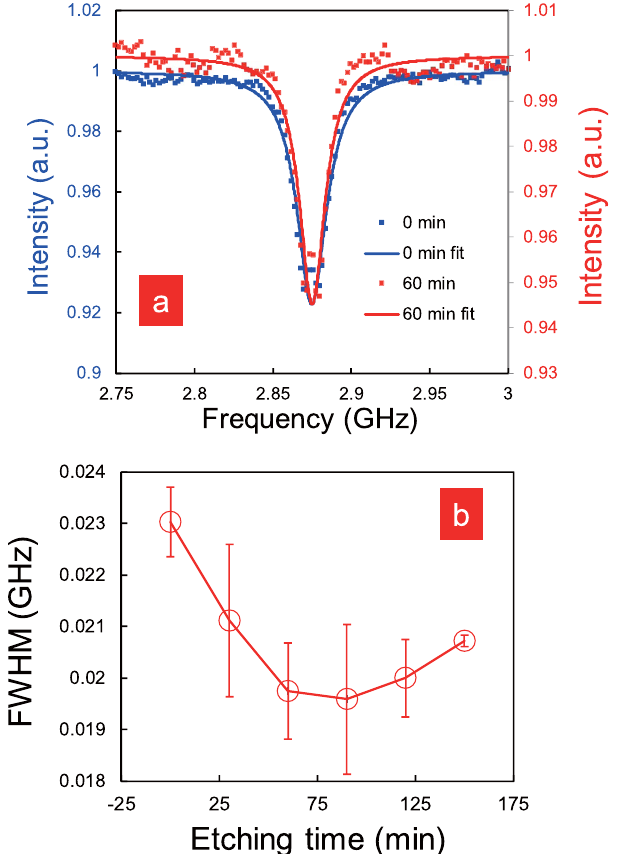
Figure 4. ( a ) ODMR spectra before (blue solid line (left-hand vertical axis); 0 min.) and after (red solid line (right-hand vertical axis); 60 min) NF etching. ( b ) FWHM value of the ODMR spectrum as a function of the NF etching